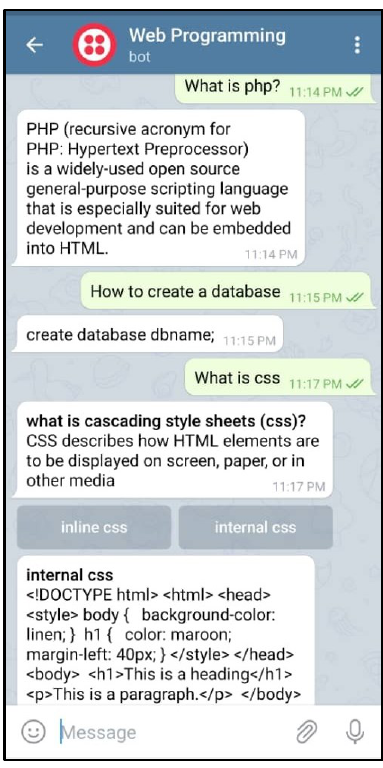
Fig. 5. Chatbot for Telegram Bot